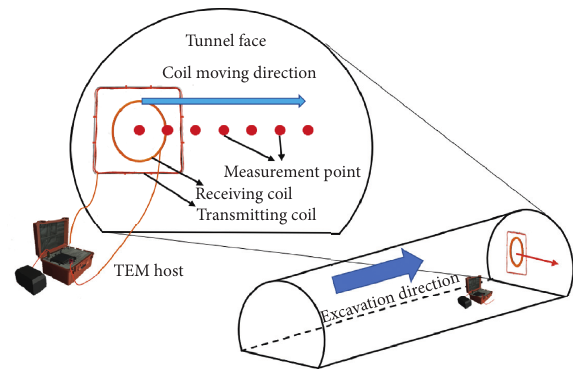
Figure 4: Schematic of instrument arrangement and observation system for TEM.